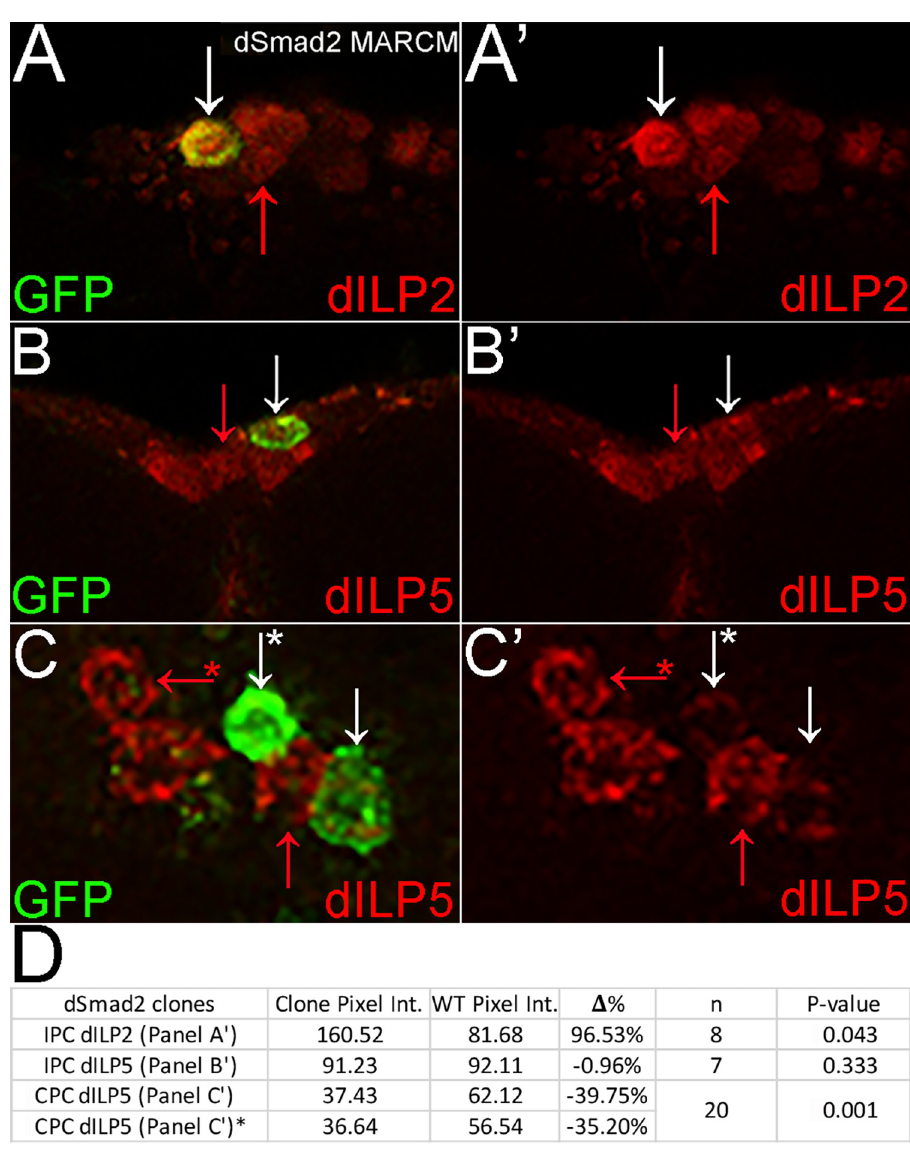
Fig 2. dSmad2 mutant clones display increased dILP2 in IPCs and decreased dILP5 in CPCs. A-C) Brains in anterior view from one day old unmated adult females with the dSmad2 mutant MARCM clone genotype. Homozygous dSmad2 clones express GFP (green) in IPCs and CPCs. IPCs are visualized with dILP2 or dILP5 (red as indicated) and CPCs with dILP5 (red). Left side two color and right side the red channel (dILPs). Paired cells for pixel intensity comparisons are indicated by arrows with white indicating a mutant and red a wild type IPC or CPC. A,A’) Single slice of IPCs. dSmad2 mutant IPC clone displays significantly increased dILP2 compared to wild type. B,B’) Single slice of IPCs. dSmad2 mutant IPC clone displays wild type dILP5 expression. C,C’) Stack of CPCs (4 slices). dSmad2 mutant CPC clones display significantly reduced dILP5 expression compared to wild type. Two comparisons are illustrated with an asterisk marking one pair. D) Table summarizing dSmad2 mutant clone pixel intensity comparisons in IPCs and CPCs. Note p-values do not refer to Δ % (an illustrative value for the cells compared in each panel), but are derived from a type 1 t-test of the mean of the differences between pairs of wild type and mutant cells shown in Table